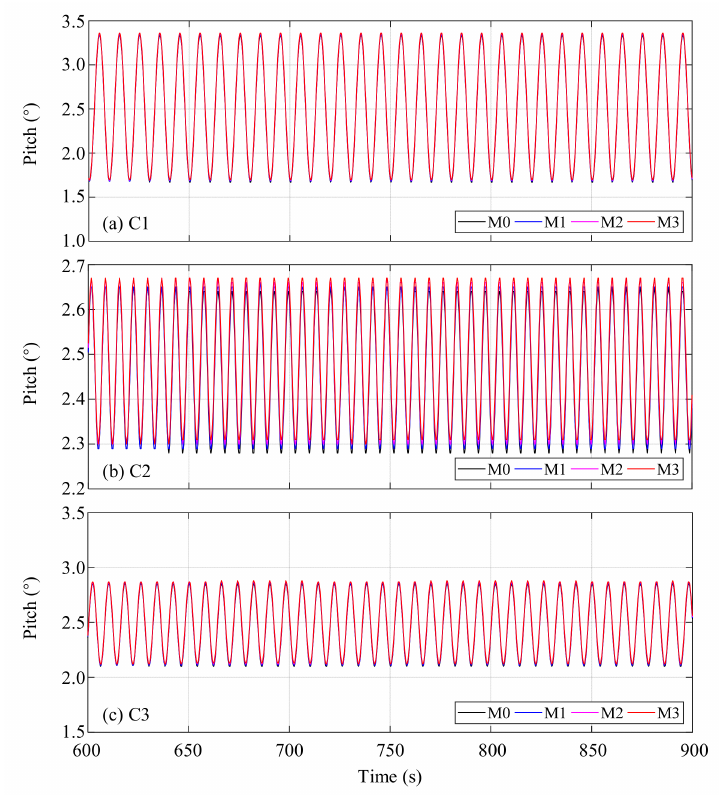
Figure 8. Wind turbine pitch movement time series with M0–3 when under: ( a ) C1; ( b ) C2; ( c )